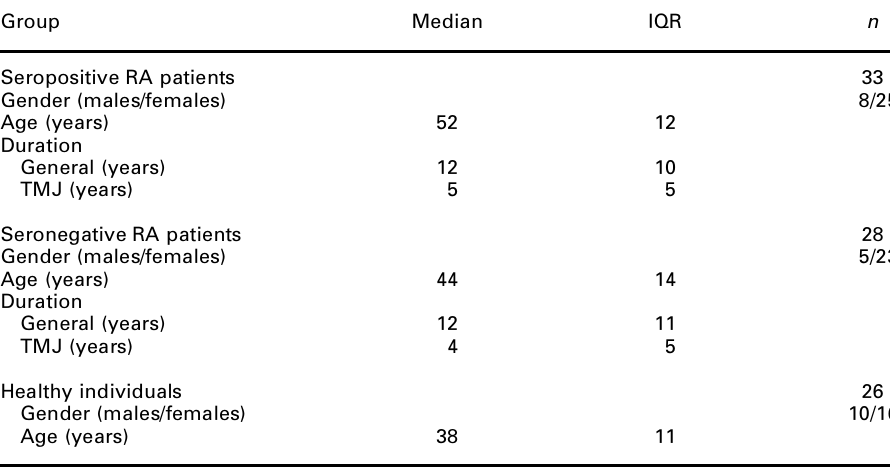
Table 1. Gender, age, duration of general and TMJ symptoms as well as number of painful musculoskeletal regions in 33 patients with seropositive RA and 28 patients with seronegative RA involving the TMJ, as well as in 26 healthy individuals